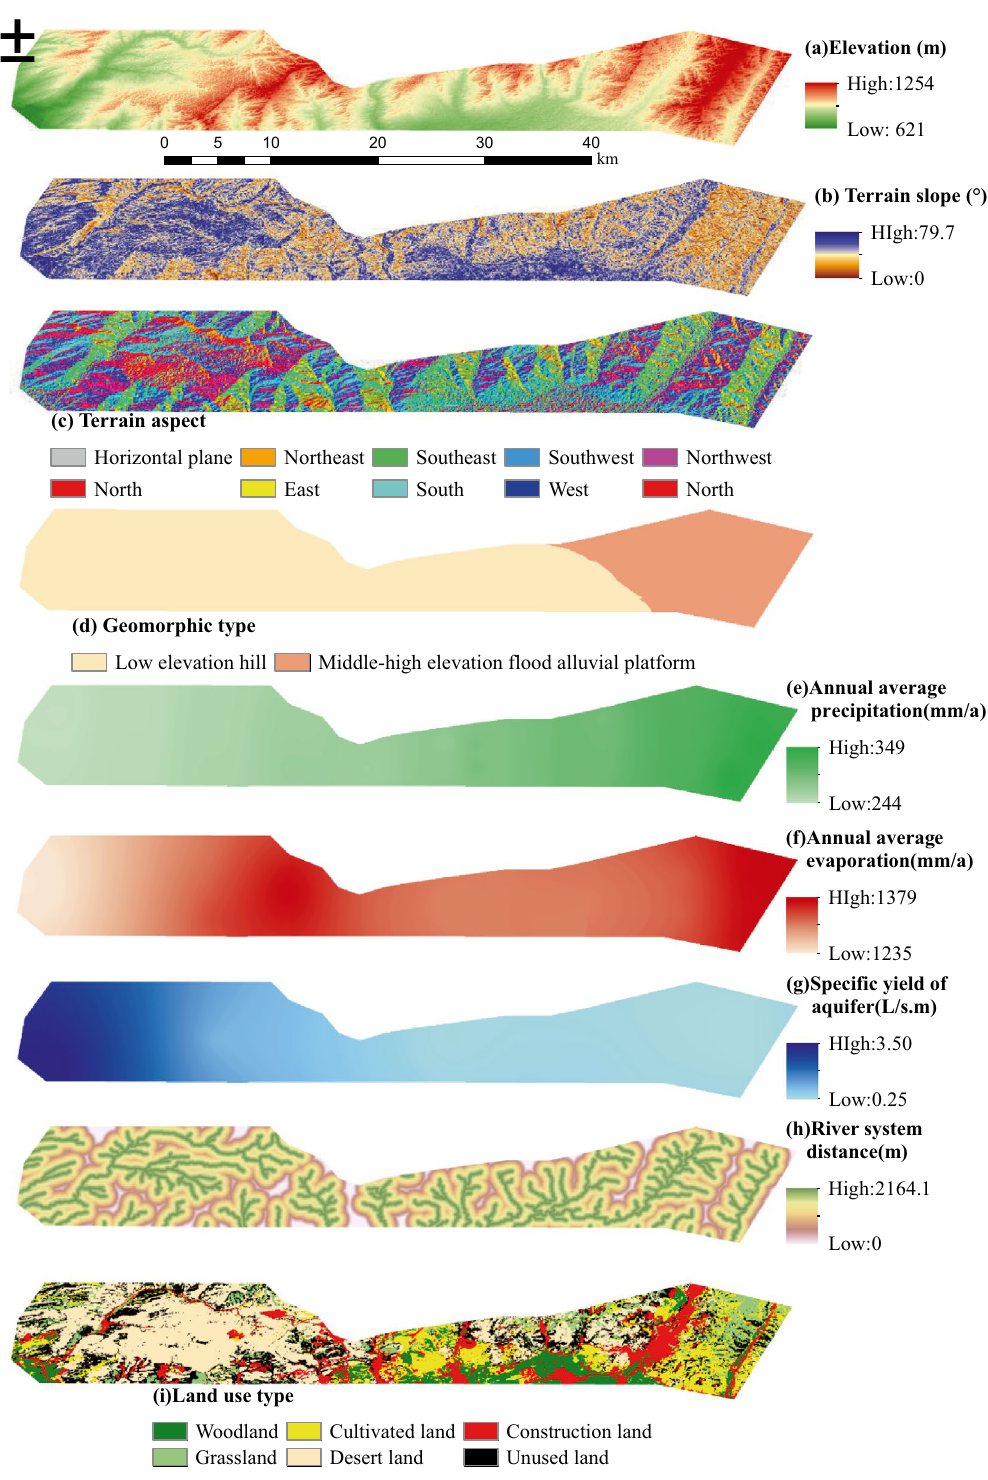
Figure 3. Eco-environmental quality evaluation indicators. The Figure is created using ArcGIS ver.10.2 (https:// www. esri.